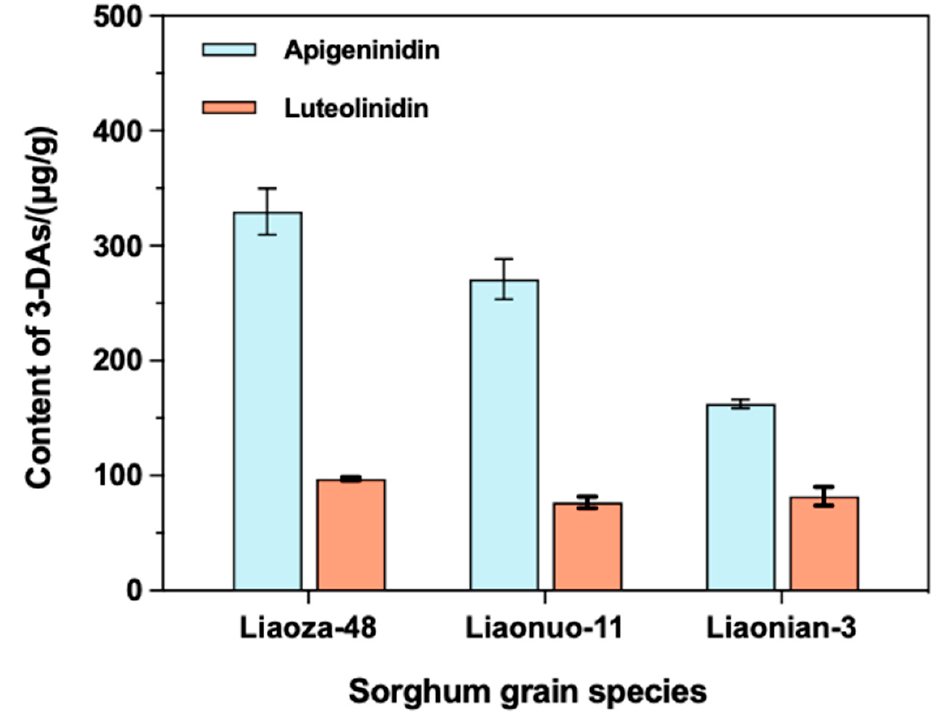
Figure 6. The content of 3-DAs of the three sorghum grain species in the forms of AE and LE. Next, appropriate amounts of sorghum 3-DAs extracted from Liaoza-48, Liaonuo-11, and Liaonian-3 were diluted to 20 µ g/mL, 50 µ g/mL, 100 µ g/mL, 200 µ g/mL, 500 µ g/mL, 1000 µ g/mL, and 2000 µ g/mL, respectively, and the scavenging activities of ABTS + radicals at different concentrations were determined. As illustrated in Figure 7c, the ABTS + radical scavenging activity of the 3-DAs extracted from the three sorghum grain species increased as the concentration of the extracted 3-DAs increased. The ABTS + radical scavenging activity of the 3-DAs extracted from Liaoza-48 was higher than that of the 3-DAs extracted from Liaonuo-11 and Liaonian-3. The IC 50 values of the three extracted sorghum 3-DAs were 168.3.79 µ g/mL for Liaoza-48, 426.6 µ g/mL for Liaonuo-11, and 357.87 µ g/mL for Liaonian-3, respectively (Figure 7d). Thus, it can be concluded that the ABTS + scavenging ability of the 3-DAs extracted from Liaoza-48 was the highest, being considerably higher than that of the 3-DAs extracted from Liaonuo-11 and Liaonian-3, while that of the 3-DAs extracted from Liaonuo-11 was the